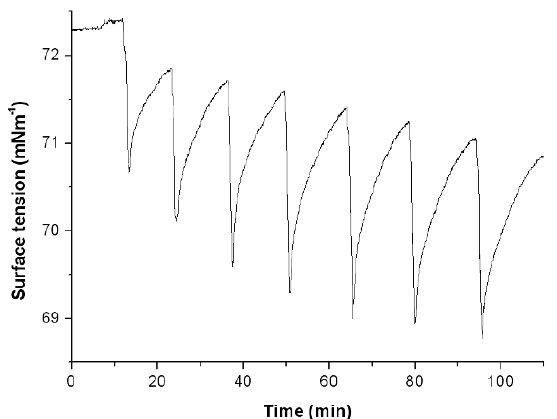
Figure 3. Spontaneous oscillations of the surface tension produced by the dissolution of a droplet of diethyl phthalate. The vessel diameter d=45 mm, the capillary immersion depth h=6.2 mm (reprinted from [33], with permission from American Chemical Society). (1 in Fig. 2 ) filled with ultrapure deionised water.